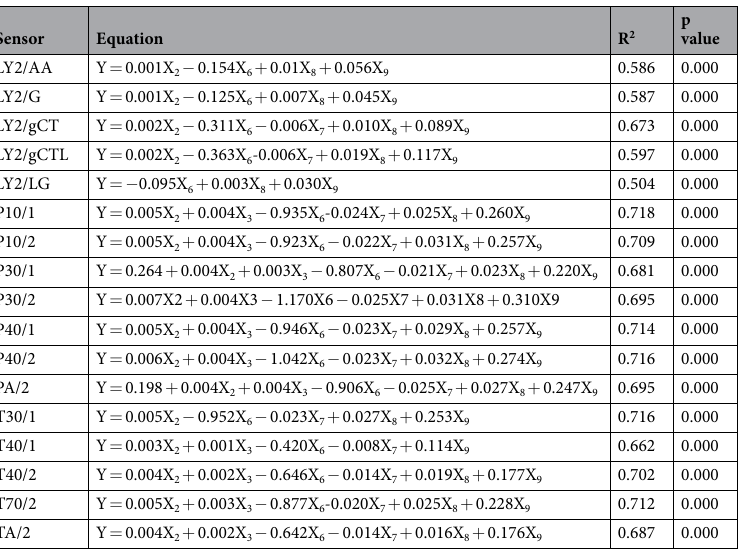
Table 3. Multi-regression analysis of the odor fingerprints and different Maca volatiles. X 1 , aromatics; X 2 , esters; X 3 , aldehydes; X 4 , olefins; X 5 , ketones; X 6 , ethers; X 7 , alcohols; X 8 , heterocyclics; and X 9 ,